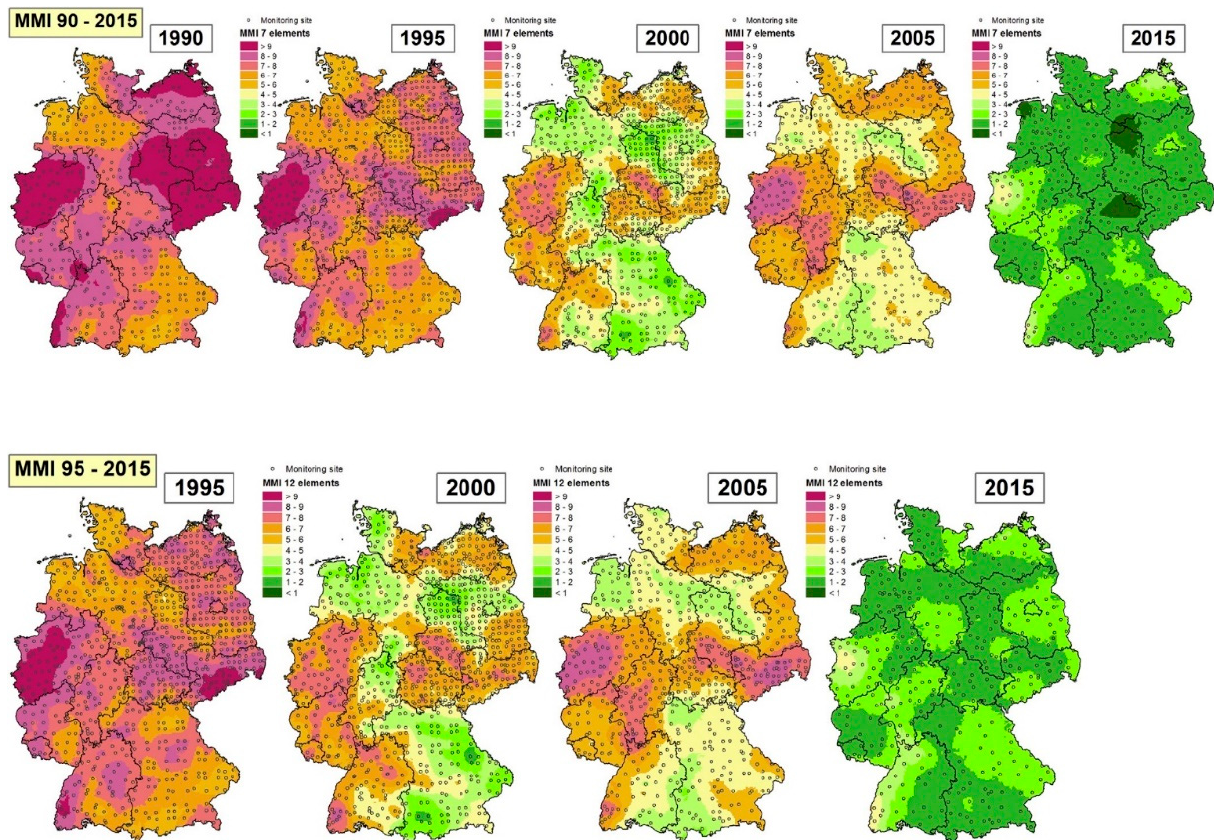
Figure 2. Spatial patterns of Multi Metal Index (MMI) integrating Cr, Cu, Fe, Ni, Pb, V, and Zn based on data collected from 1990 to 2015 ( Above ). Spatial patterns of MMI integrating Al, As, Cd, Cr, Cu, Fe, Hg, Ni, Pb, Sb, V, and Zn based on data collected from 1995 to 2015 ( Below ).